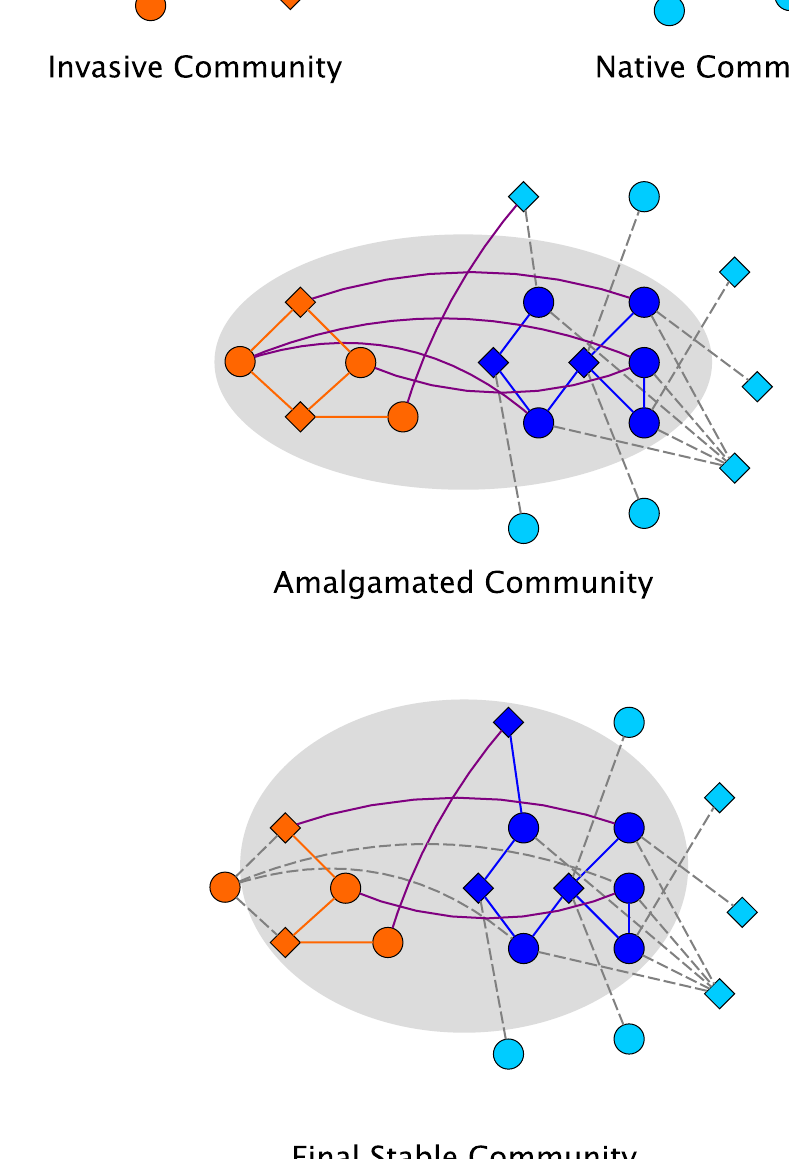
Fig 2. The invasion process and types of communities considered in this report. For simplicity in this schematic example, the arrowheads describing the nature of the interactions (Fig 1) are omitted. (a) Both the invasive community and the